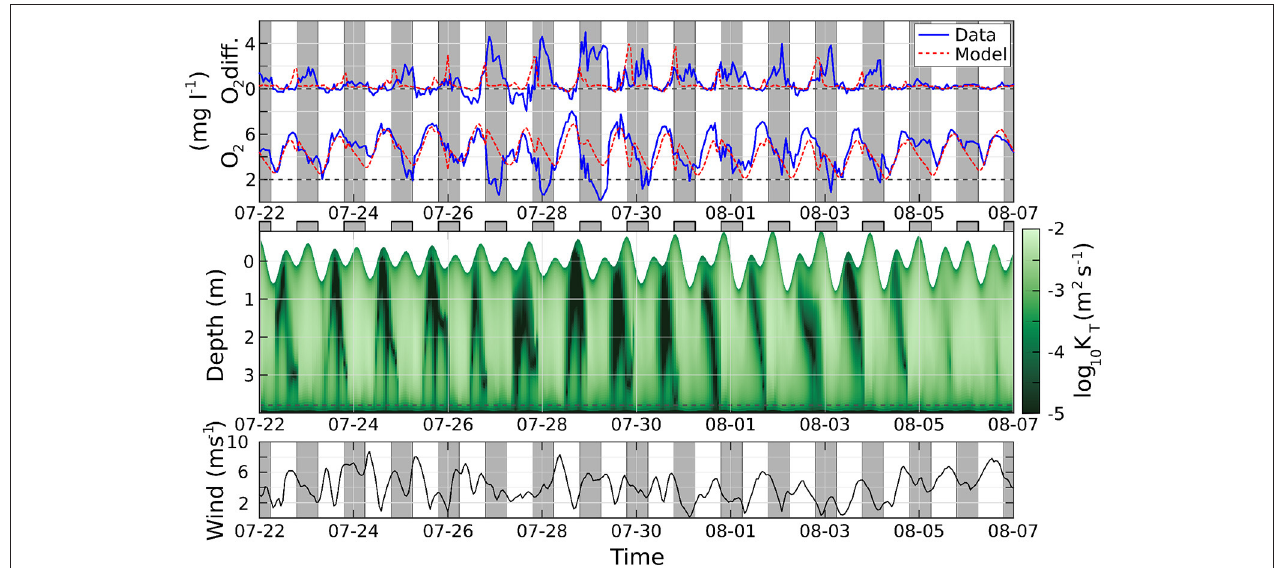
FIGURE 7 | Top , above: difference of oxygen concentration between the midwater and bottom sensors; below: oxygen concentration at the bottom. Solid blue lines are observations, dashed red lines from the model. Middle : eddy diffusion coefficient, logarithmic scale; the position of the surface changes with time according with the tide. Bottom : wind speed. Gray regions indicate